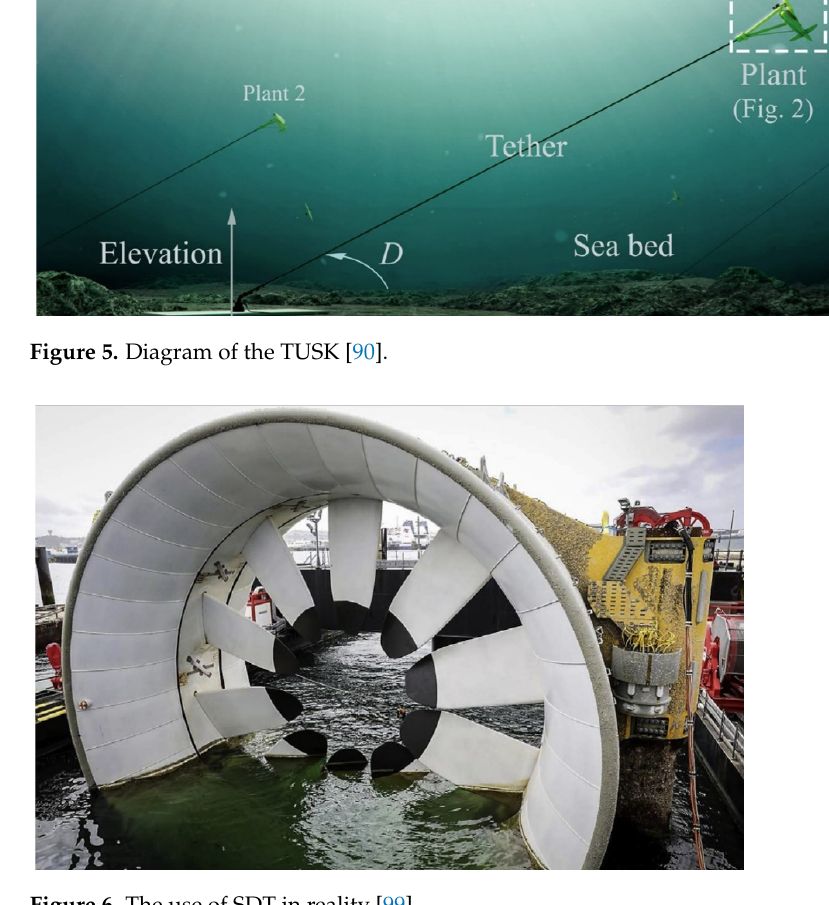
Figure 6. The use of SDT in reality